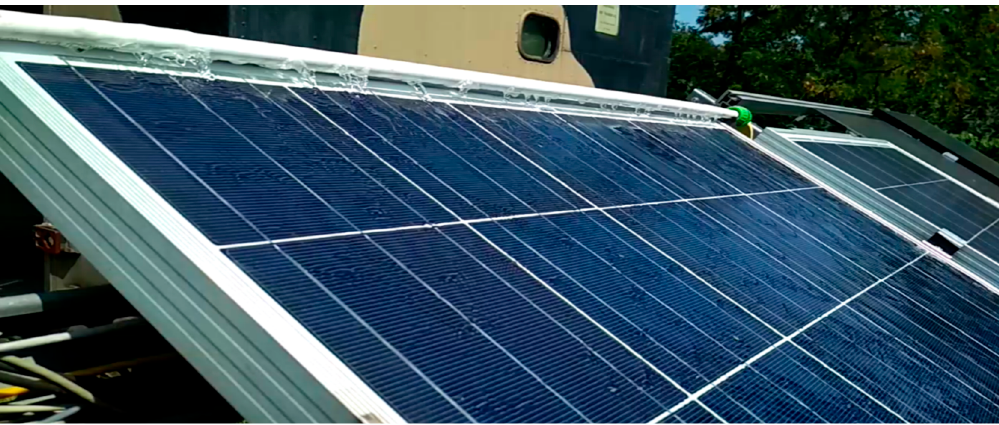
Figure 4. Research stand with cooling by means of a water film.